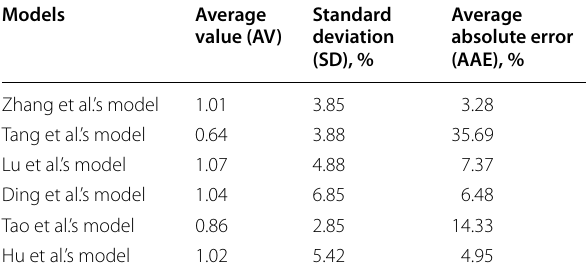
Table 4 Evaluation results of existing models for